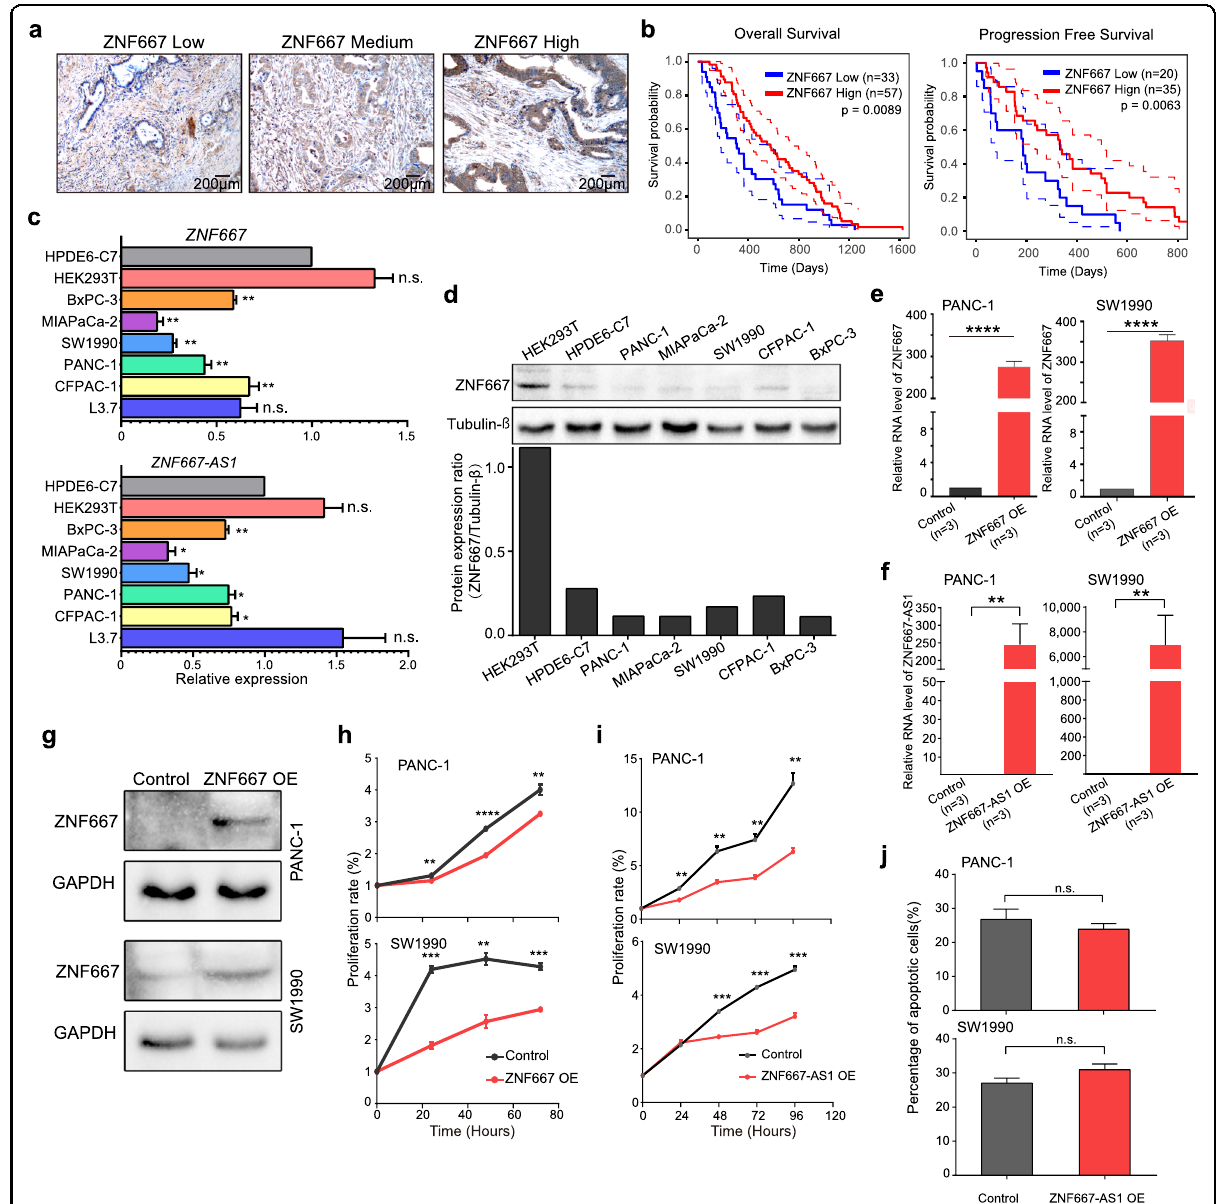
Fig. 3 ZNF667 and ZNF667-AS1 as novel markers for prognosis in PDAC. a Immunohistochemistry of ZNF667 shows variations of abundance across patients using the tissue microarray analysis. b Overall survival and progression-free survival of self-collected PDAC patients grouped by the abundance of ZNF667. c Relative abundance of ZNF667 and ZNF667-AS1 to ACTB mRNA in normal pancreas cells (HPDE6-C7), human embryonic kidney cells (HEK293T), liver metastasis pancreas cancer cells (L3.7), and the pancreas cancer cells detected by RT-qPCR. All pancreas cancer cells showed a decreased level of ZNF667 and ZNF667-AS1 . * P < 0.05; ** P < 0.01. d Immunoblot showing the decreased abundance of ZNF667 in multiple pancreas cancer cell lines. The abundance was calculated at the bottom. e , f Validation of ZNF667 and ZNF667-AS1 overexpression (OE) in two pancreas cancer cell lines. ** P < 0.01; **** P < 0.0001. g Immunoblot showing the abundance of ZNF667 in PANC-1 and SW1990 cells before and after overexpression. h , i Proliferation evaluation (CCK8-positive cell ratio) after ZNF667 and ZNF667-AS1 overexpression in two pancreas cancer cell lines. n = 3 for each time point. ** P < 0.001; **** P < 0.00001. j Evaluation of cellular apoptosis after ZNF667-AS1 overexpression in two pancreas cancer cell lines. n.s., no signi fi